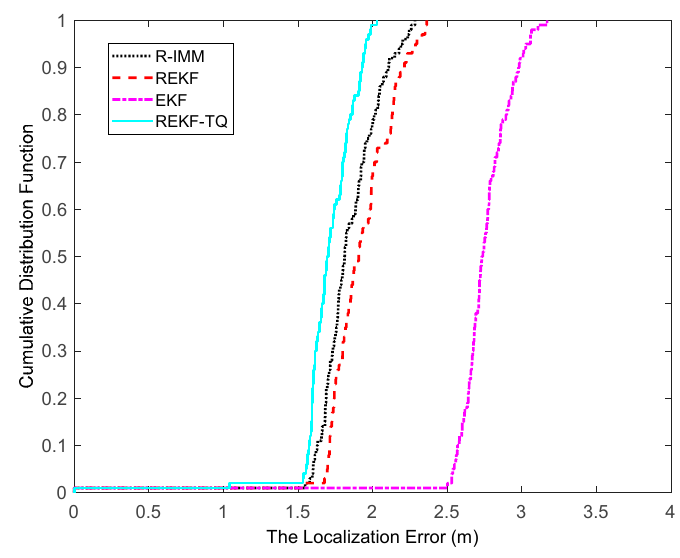
Figure 9. The localization error CDF.